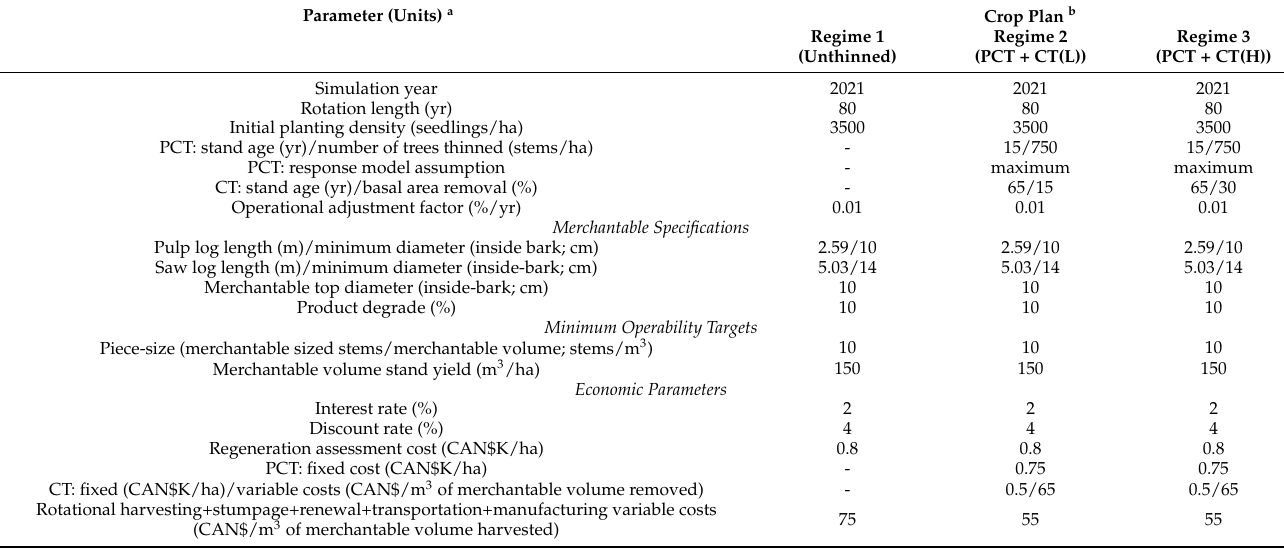
Table 1. Input parameters for the example CP DSS simulations for natural-origin jack pine stands situated on medium-to-good quality sites subjected to PCT and CT treatments (Figure